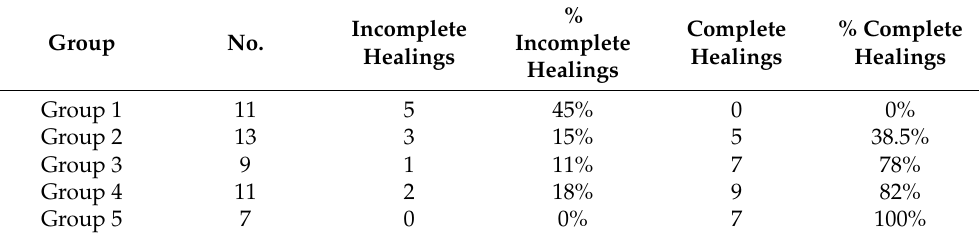
Table 3. Complete and incomplete healings for each group.